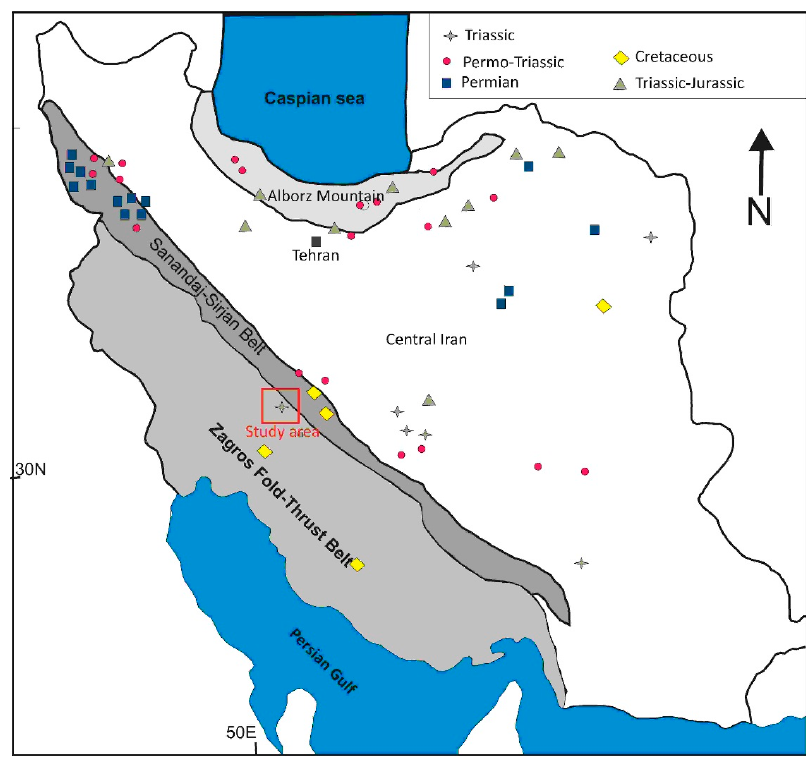
Figure 1. Schematic map of Iran with location of the Zagros Fold Belt, Alborz Mountain, Central Iran, and distribution of bauxite deposits.